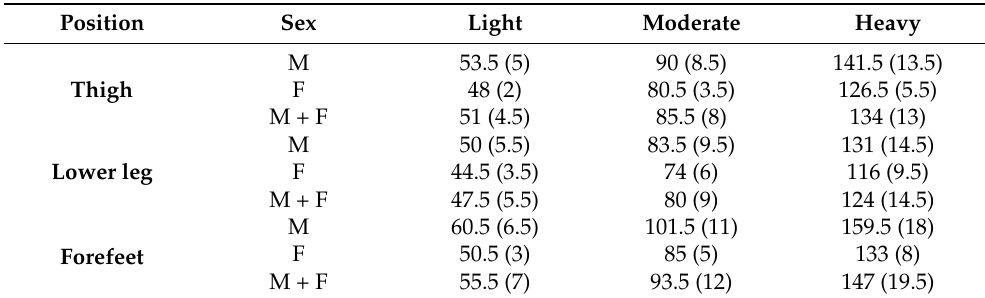
Table 1. Mean (and the standard deviation) for the elastic band force (in N) when stretched around each position tested subjects’